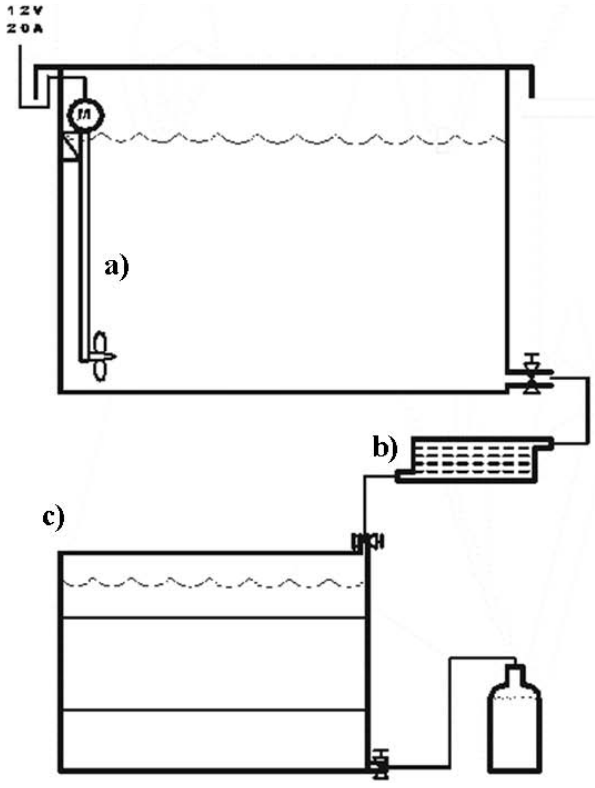
Fig. 1. Schematic drawing of the setup used for the preparation of salt brine in large amounts. An electric outboard motor (a) in the mixing tank speeds up the dissolution of salts, enabling prepara- tion of nearly saturated solutions within a few hours. Produced so- lutions can be further processed (e.g. run over filters or purifying columns) (b) and stored in intermediate bulk containers (c) and dis- pensed into suitable carboys for quantitative addition into the meso- cosms using the